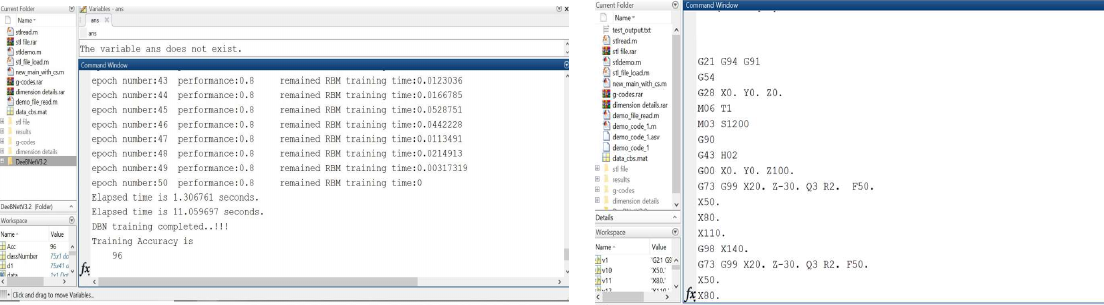
Fig.11. Screenshots of execution of code in MATLAB (counter-sinking)